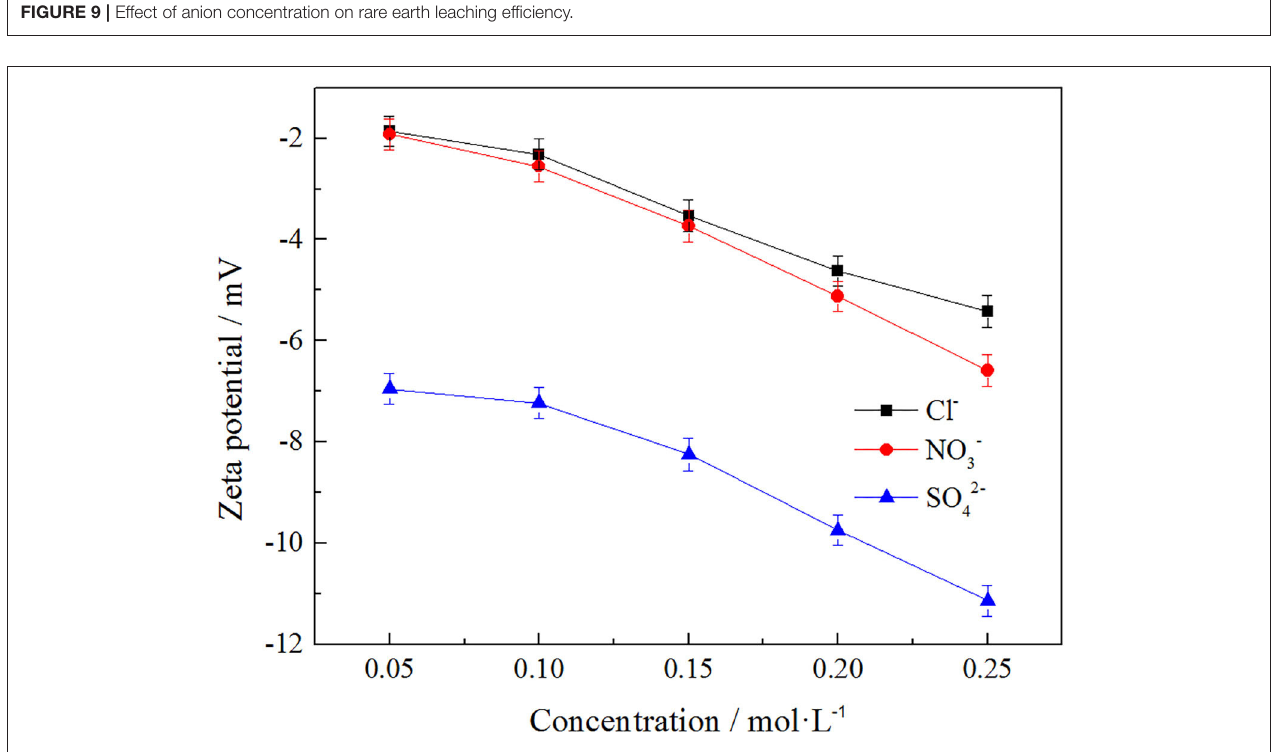
FIGURE 10 | Effect of anion concentration on surface potential of clay minerals. The relationship between rare earth leaching efficiency and zeta potential was fitted when the electrolyte solution anions were Cl − , NO − , and SO 2 − . The fitting results are shown in Figure 11 , 3 4 and the fitting equations are shown in Table 3